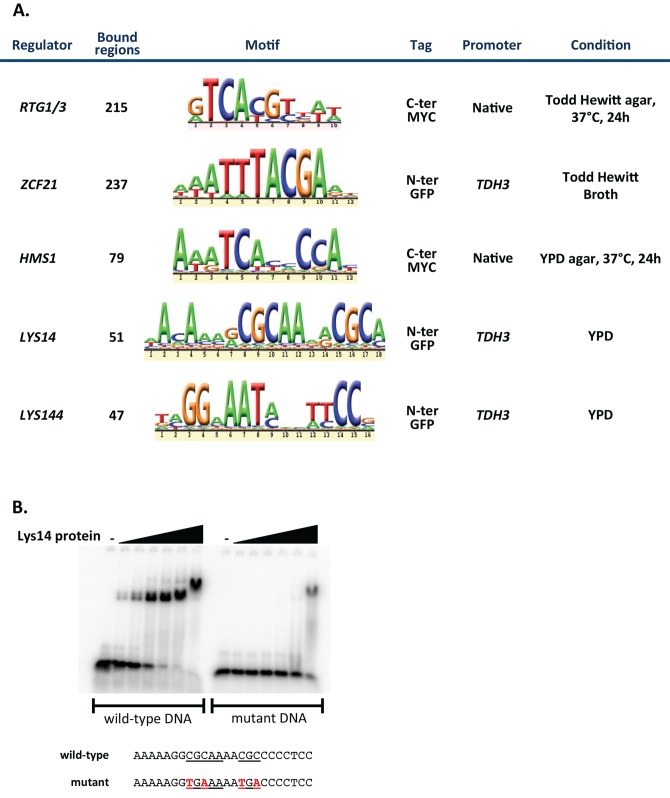
Genome-wide identification of DNA regions bound by TRs.(A) Summary of experimental conditions and results of ChIP. ChIP-chip was carried out for each of the identified regulators under the conditions described. The number of intergenic regions bound by each regulator is indicated. The DNA motifs shown were derived de novo from our ChIP-chip data and are significantly enriched in the bound regions. (B) The C. albicans Lys14 protein binds in vitro to the DNA sequence identified by ChIP-chip. The DNA-binding domain of the C. albicans Lys14 protein (amino acids 1–236) was N-terminally fused to 6His and to the maltose binding protein, expressed in Escherichia coli and purified with Ni-NTA columns. 32P-labeled 24-nt DNA fragments (∼0.4 nM) containing the predicted wild-type or mutant Lys14 binding site were incubated with increasing concentrations of purified Lys14 protein (0, 0.039, 0.156, 0.625, 2.5, 10, and 40 nM) for 30 min at room temperature in standard EMSA buffer and resolved in 6% polyacrylamide gels run with 0.5× TGE. The DNA fragment tested corresponds to the OCH1 promoter. The point mutations that we inserted to disrupt the putative binding site are indicated in red.